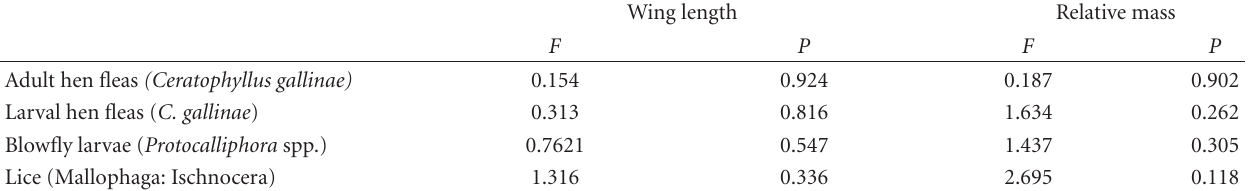
Table 2: GLMM analyses of ectoparasite abundance (divided into quartiles) and great tit o ff spring quality ( n = 93 chicks in 20 nests). Wing length Relative mass F P F Adult hen fleas (Ceratophyllus